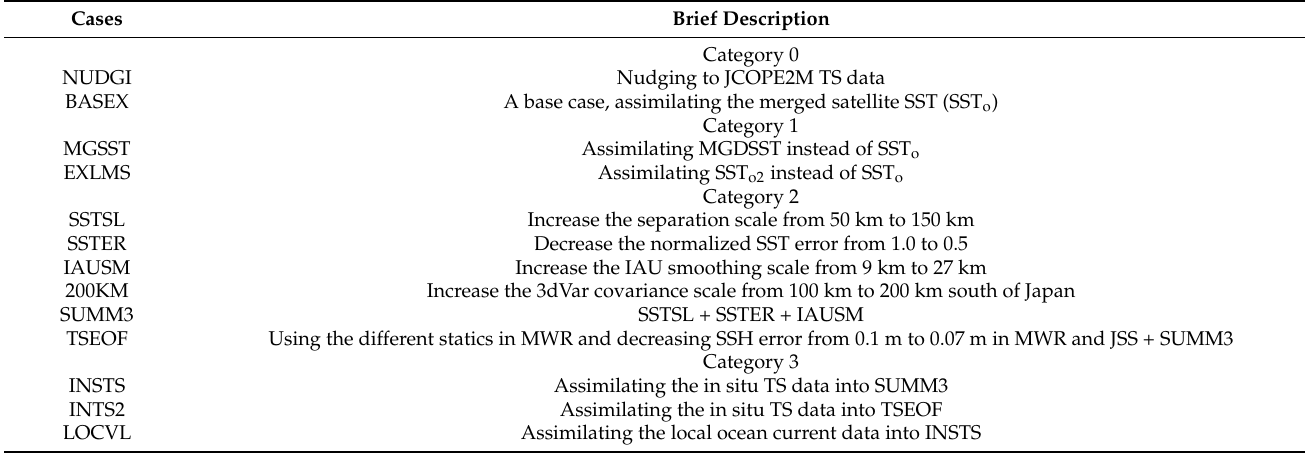
Table 1. Brief descriptions of all experiments.